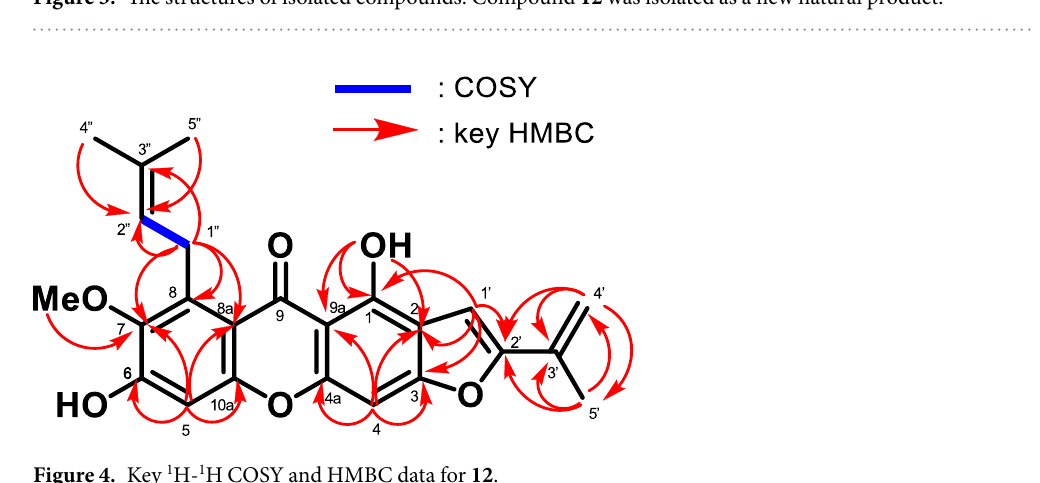
Figure 3. The structures of isolated compounds. Compound 12 was isolated as a new natural product.